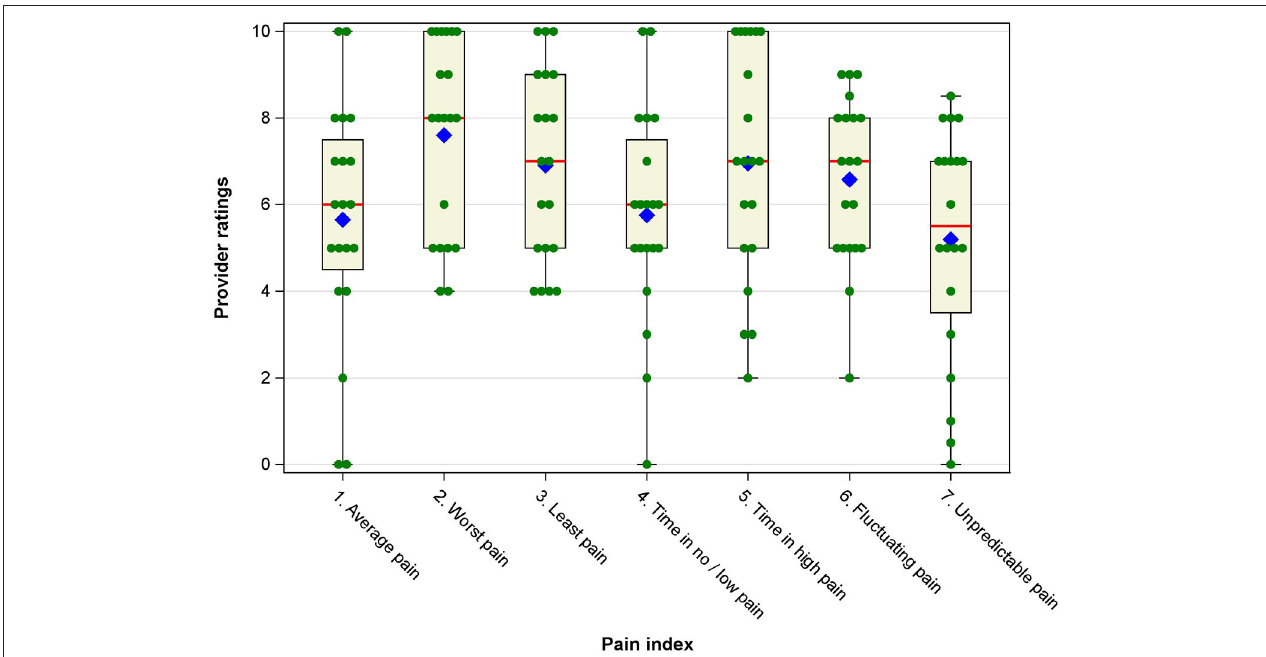
FIGURE 1 | Box-and-whisker plots of provider ratings of importance/usefulness of the pain intensity indices. Blue diamonds represent the mean, red vertical lines represent the median, boxes represent the 25th and 75th percentile, whiskers represent the range of ratings, and green filled circles represent individual provider ratings for each pain index.